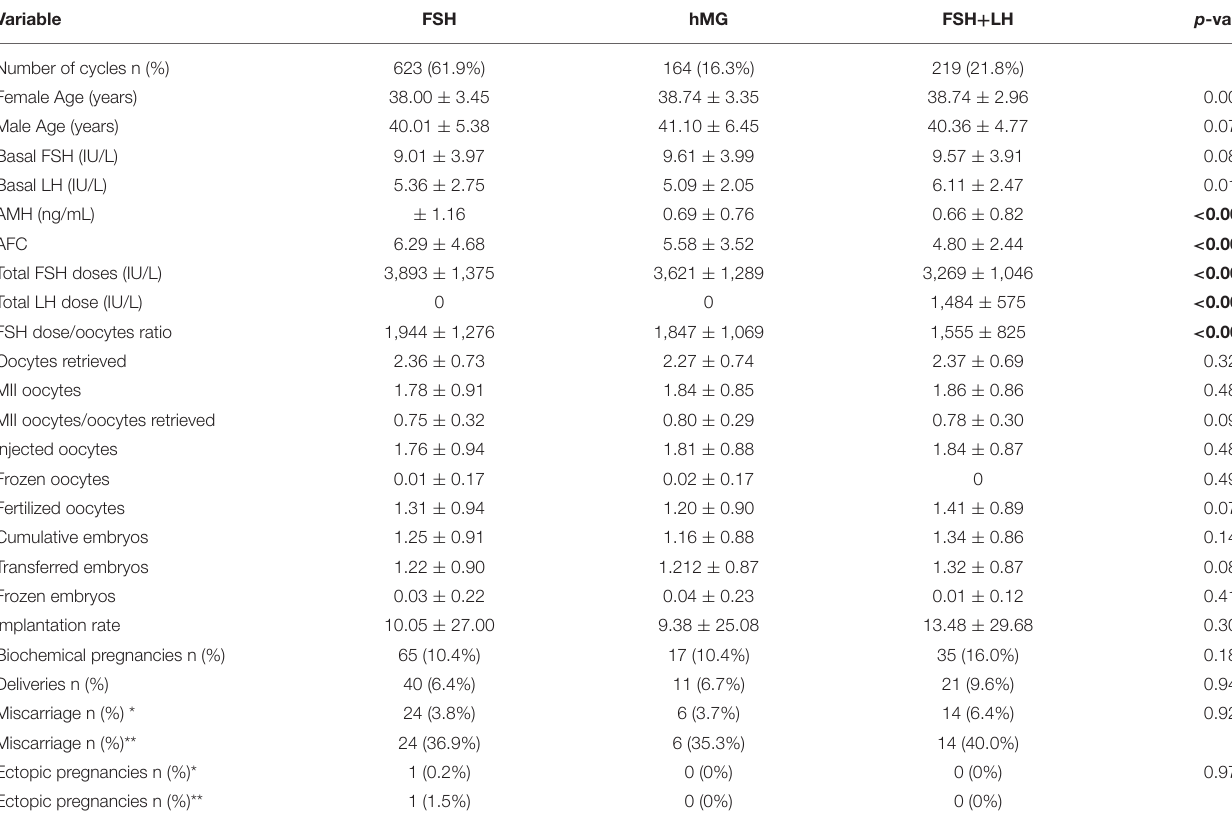
TABLE 2 | ART outcomes in low responder women.